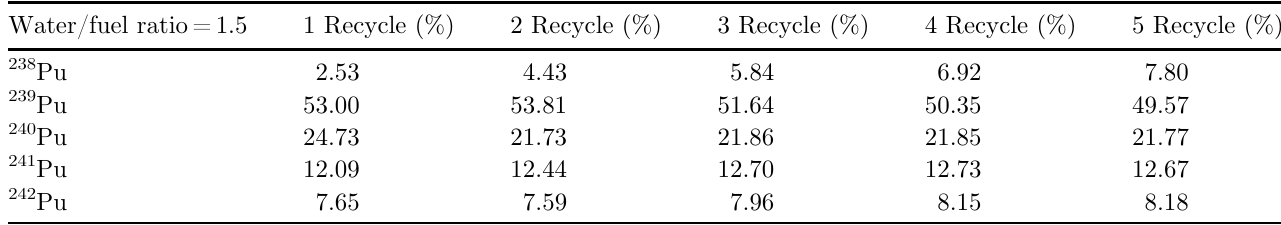
Table 4. Plutonium isotopic composition for FA with water/fuel ratio = 1.5. Water/fuel ratio = 1.5